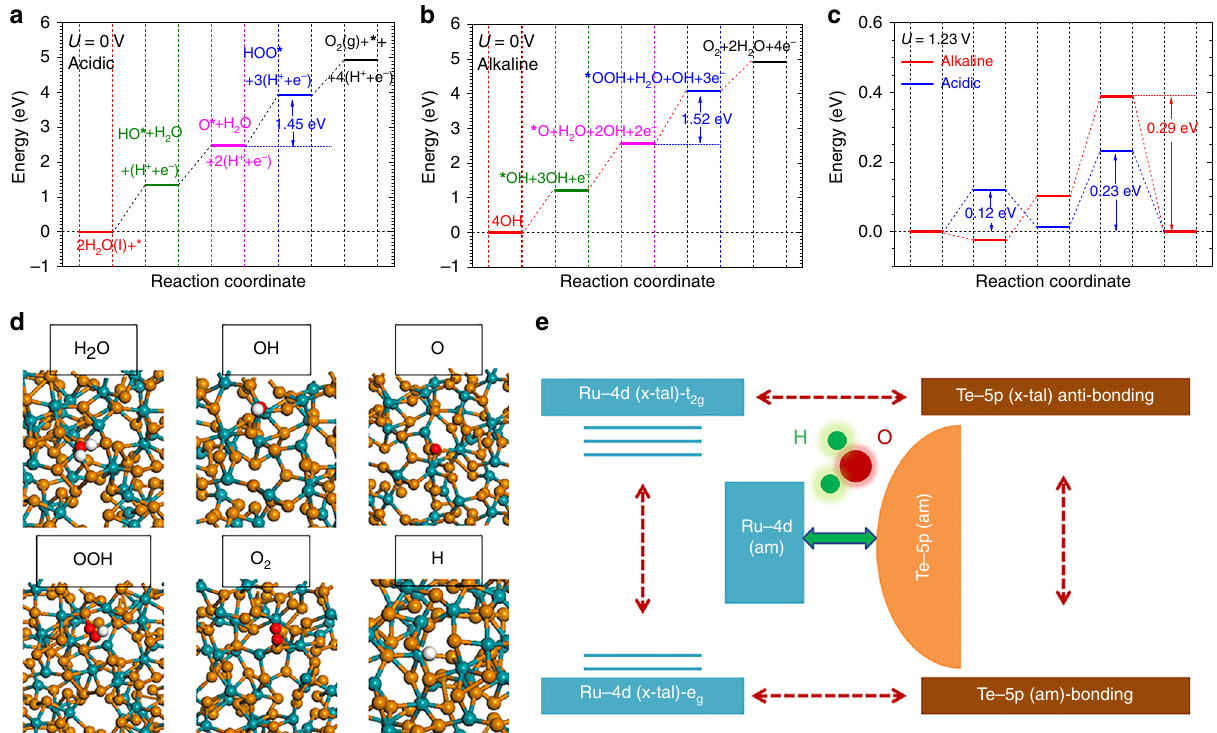
Fig. 3 OER energy pro fi le and activity plot. a The free energetic pathways for acidic OER at U = 0 V. The corresponding reaction mechanism in the acidic is shown in the plot and calculation setup. b The alkaline OER pathway at U = 0 V. The different reaction mechanisms with the acidic OER based on key adsorbates and co-reactants is supplied in the plot and calculation setup. c The OER pathways of acidic and alkaline conditions at U = 1.23 V. d Local structural con fi gurations of initial reactant, intermediates or fi nal product on the amorphous RuTe 2 surface. e Schematic diagram for illustrating the amorphous RuTe 2 boosting the OER performance via highly ef fi cient electron-transfer